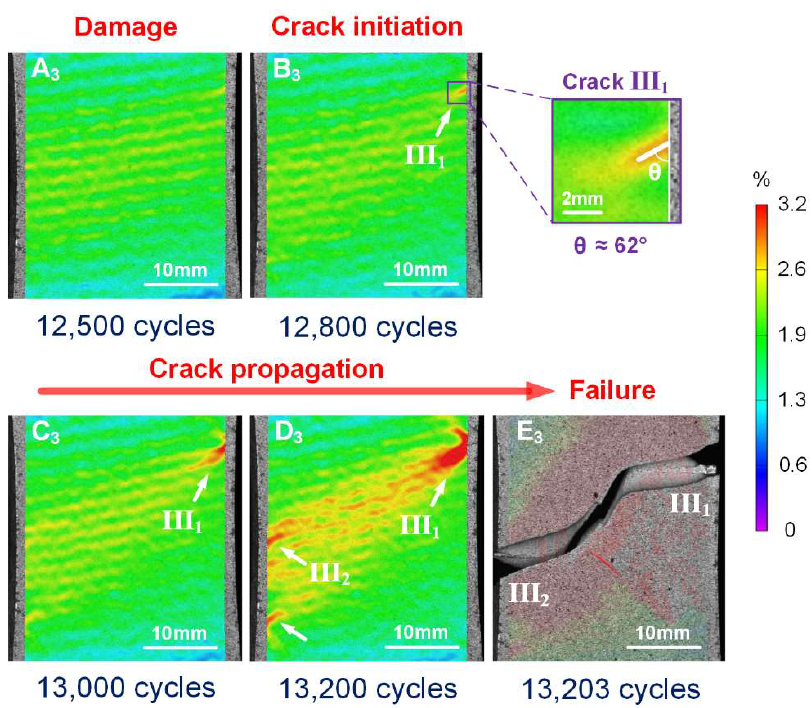
Figure 9. Measured contour-plot distribution of evolution of maximum tensile strain, facilitating visualization of damage, crack initiation and propagation for corrosion time of 96 h.